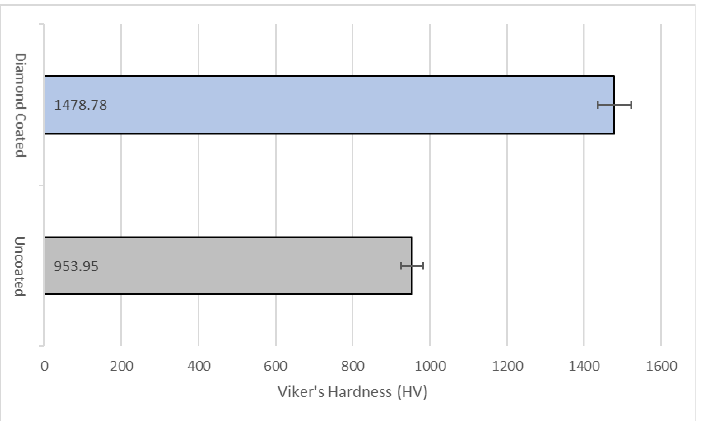
Figure 10. Average Vickers hardness values of the DLC-coated and un-coated WC tool inserts.